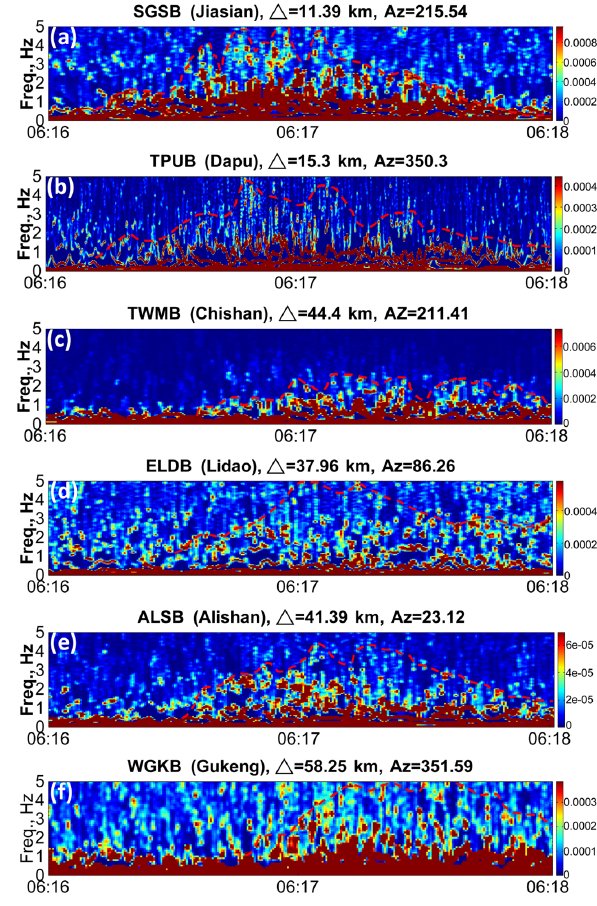
Figure 13 The HHT time-frequency spectra of the six seismic stations. The red dashed lines encircle the most significant spectra ranges for the Shiaolin landslide.